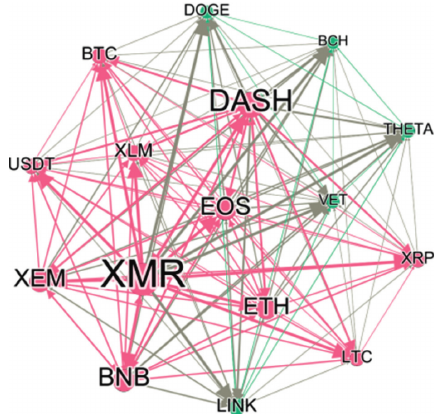
Figure 37: Risk spillover under R2.